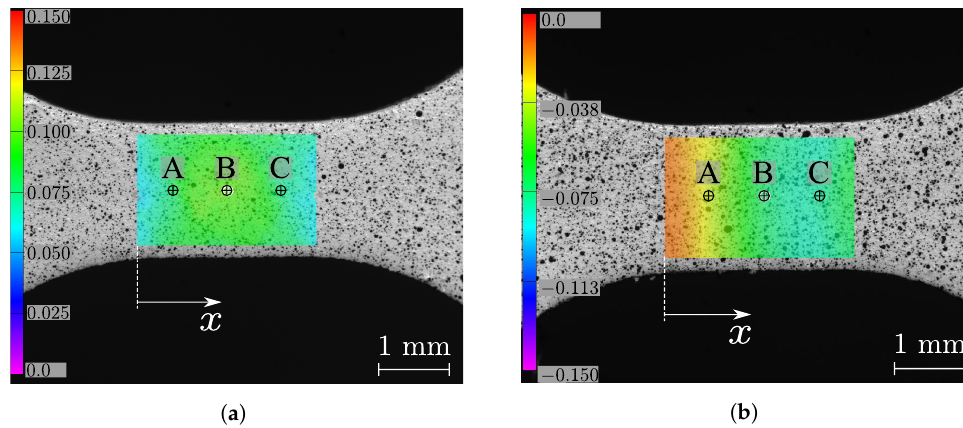
Figure 3. Points of reference used in evaluating the reconstruction of the ε xx strain signal with regard to the DIC settings and as a function of the VSG for both ( a ) tension and ( b ) compression tests.